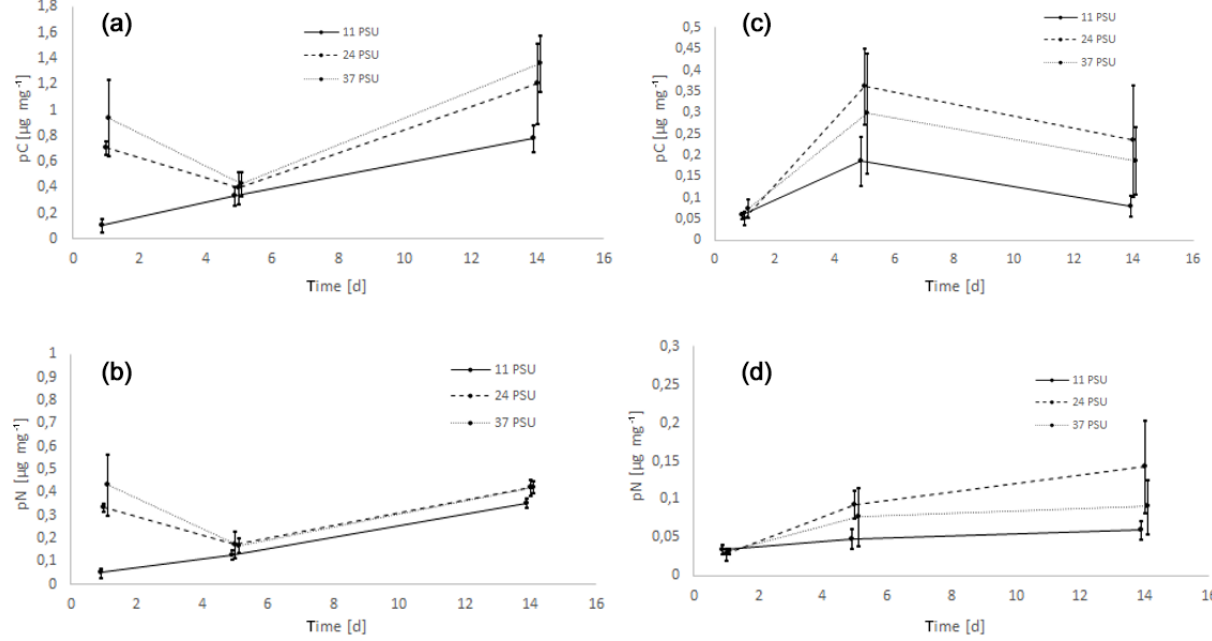
Figure 1. Time kinetics of algal C and N uptake (pC, pN) by (a, b) A. tepida and (c, d) H. germanica . pC and pN were measured at three salinity levels: 11, 24 and 37